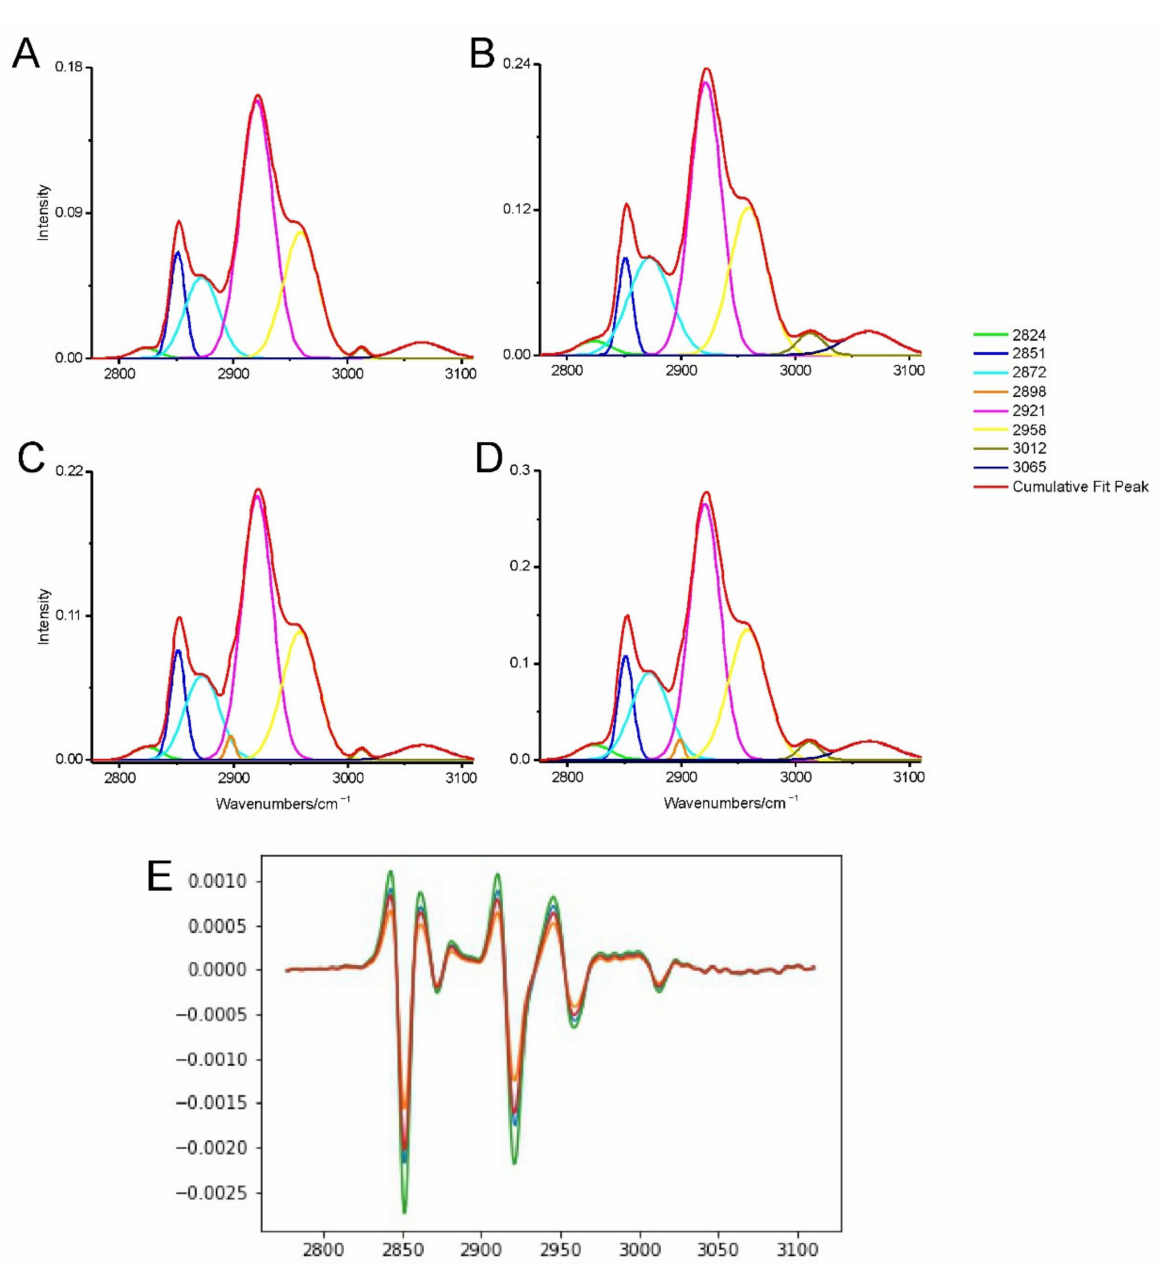
Figure 2. The deconvoluted and second derivative spectra of the lipid region (region B) in the 3110–2800 cm − 1 : ( A ) hippocampus spectra of the control sample. ( B ) hippocampus spectra of the TP-315 treated sample. ( C ) cerebral cortex spectra of the control sample. ( D ) cerebral cortex spectra of the TP-315 treated sample. ( E ) second derivative spectra of control mouse hippocampus (orange spectrum), hippocampus of the treated mouse (blue spectrum), cerebral cortex of the control mouse (red spectrum) and cerebral cortex of the treated mouse (green spectrum). The bands are described in the Table